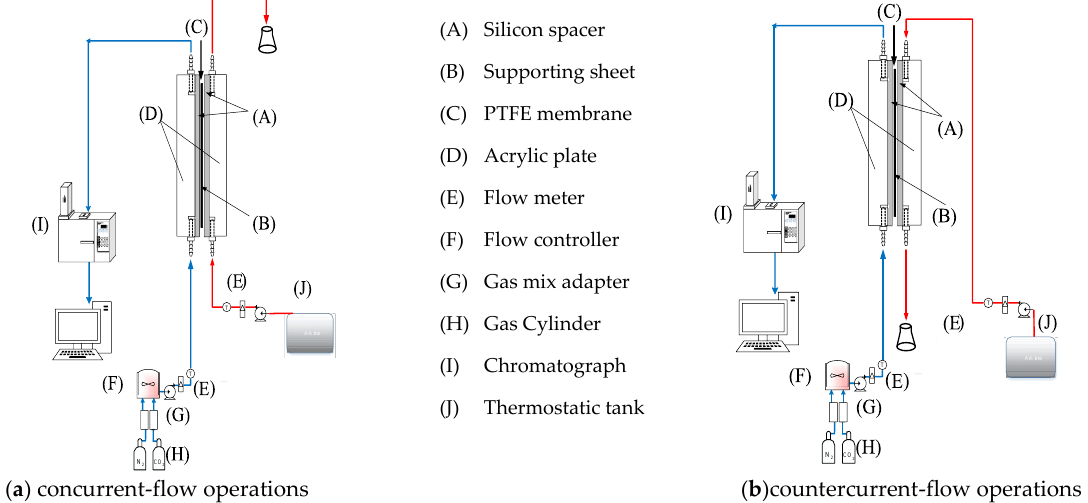
Figure 5. Experimental setup for parallel-plate membrane gas–liquid contactors. ( a ) concurrent-flow operations; ( b ) countercurrent-flow operations.